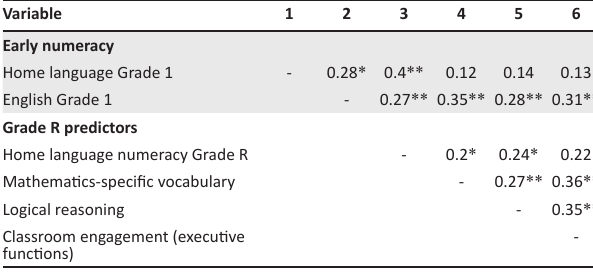
TABLE 2: Correlations between predictor and outcome